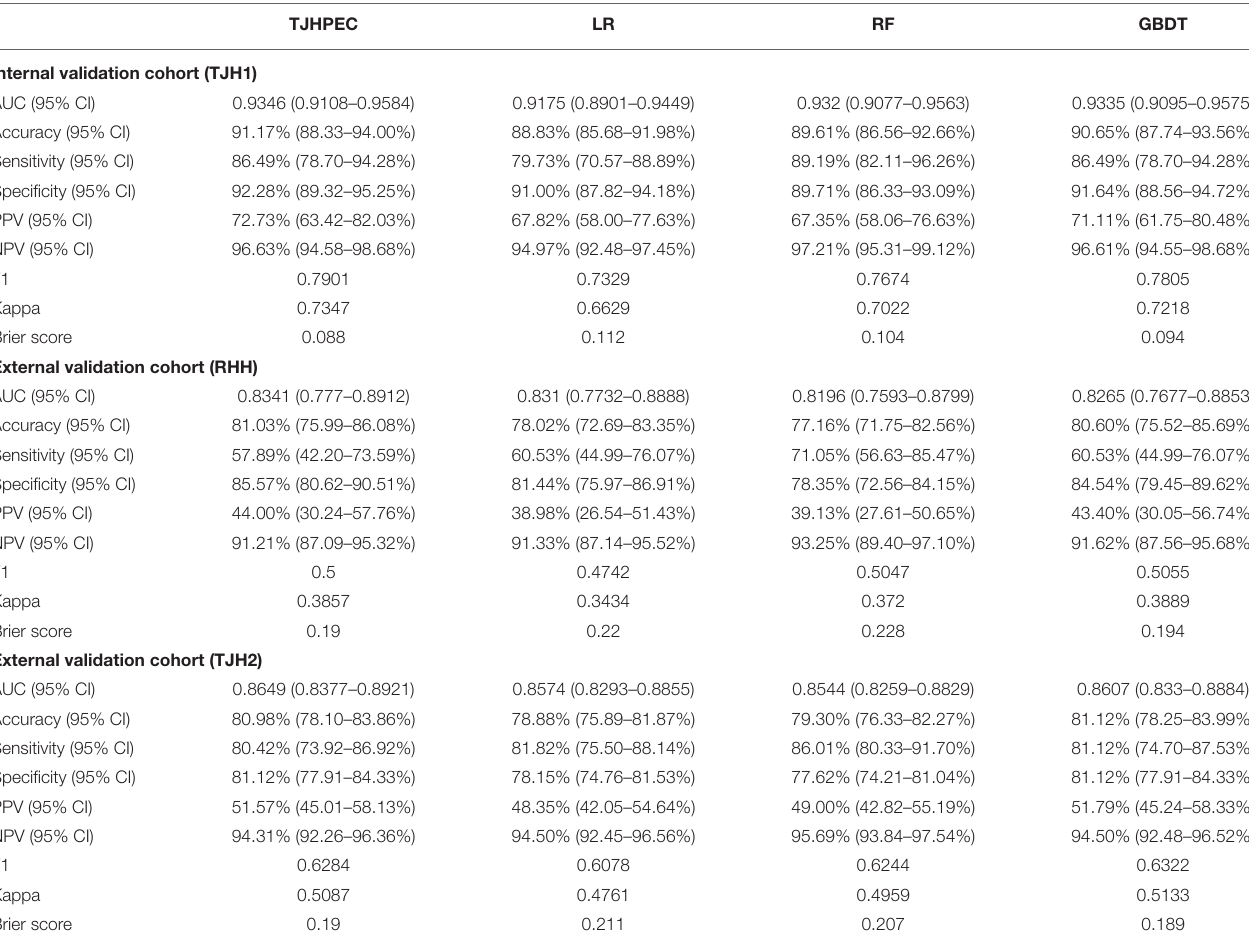
TABLE 2 | Performance indices of the four predictive models for total EC in the validation